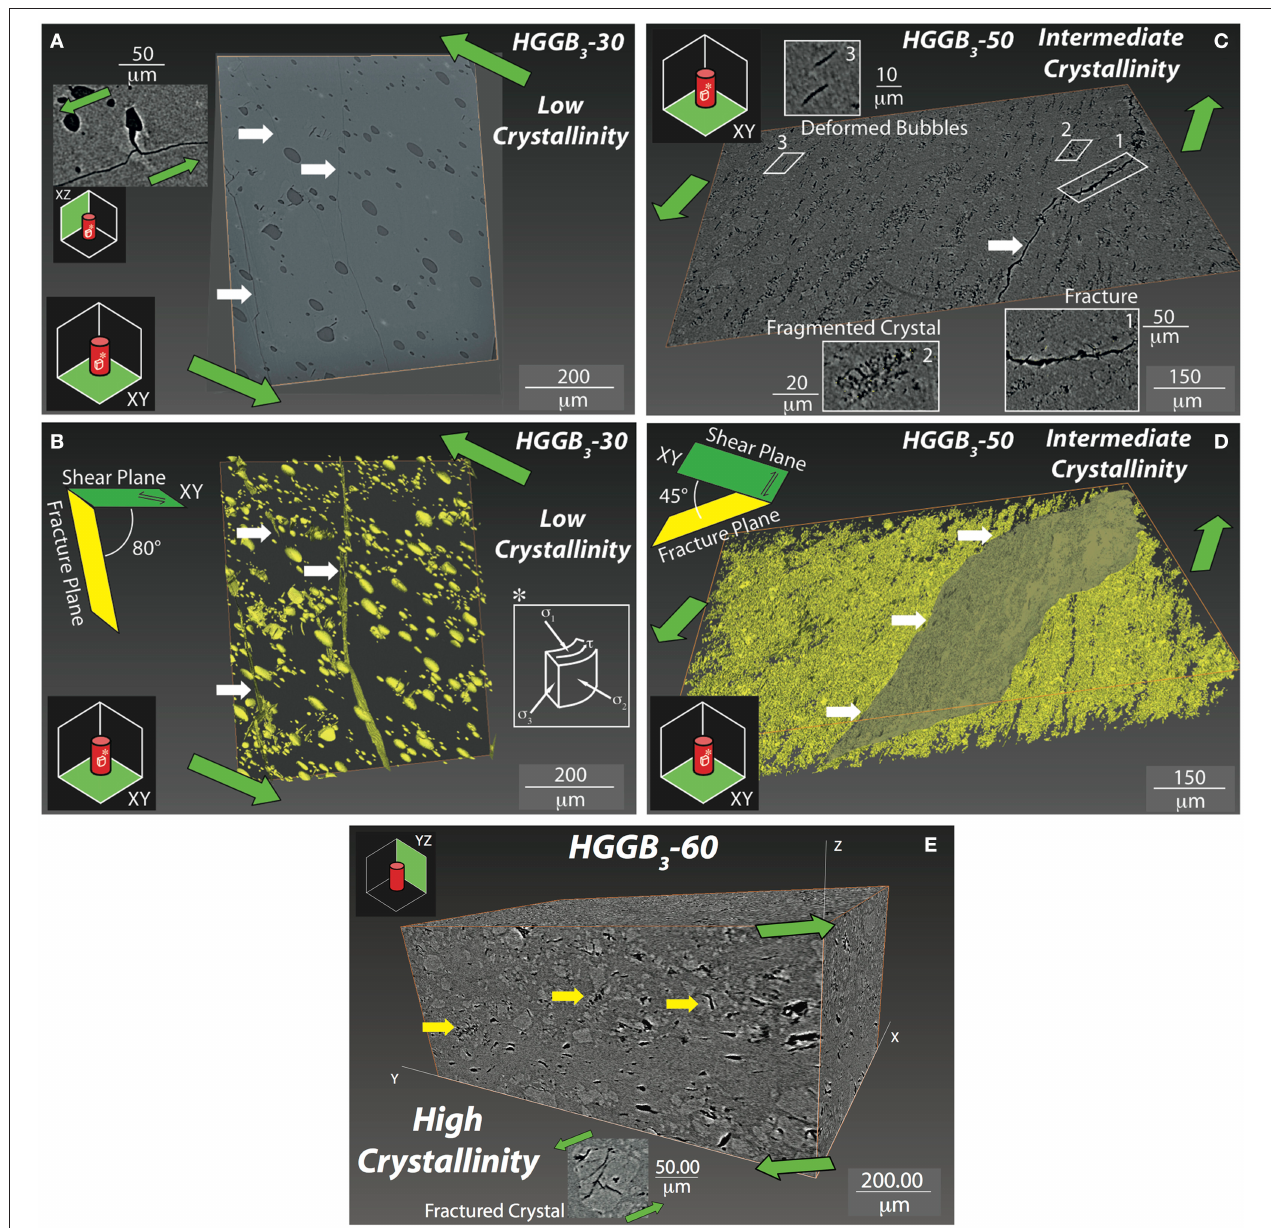
FIGURE 2 | Synchrotron-based X-ray tomographic microscopy virtual slices (whose positions in the 3D space are highlighted by the green planes reported in the reference frame) and corresponding 3D microstructural renderings of three representative samples. (A,B) P1271 with an inset from sample P1269 (HGGB 3 -30; low crystallinity); (C,D) P1268 (HGGB 3 -50; intermediate crystallinity). In (A) and ( C) black objects are bubbles and fractures, the dark gray area is silicic glass and light gray objects are quartz crystals. In (B) the principal stress configuration imposed during torsion experiments of multiphase samples is indicated. In (B) and (D), bubbles and fractures are highlighted by yellow color. White arrows indicate macroscopic fractures in the samples; in (D) the macroscopic fracture plane is marked with brown color. (E) Non-fractured sample portion at high crystallinity (HGGB 3 -60, run OR119) exhibiting highly deformed bubbles within the shear band and the presence of fractured crystals (indicated by yellow arrows and shown in the inset image from the same sample provided as Movie 1/Presentation 1 ZIP ) due to intensive particle collisions during deformation.